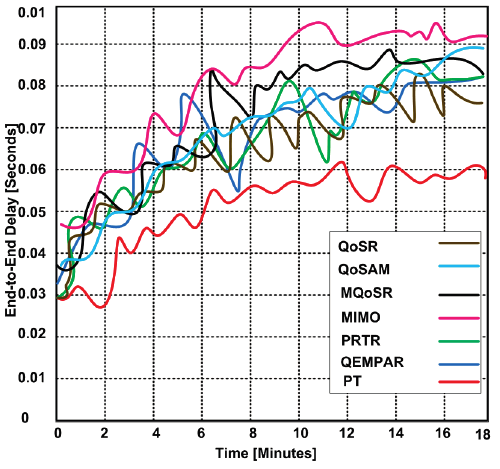
Figure 8. End-to-end delay of routing protocols for different time intervals.